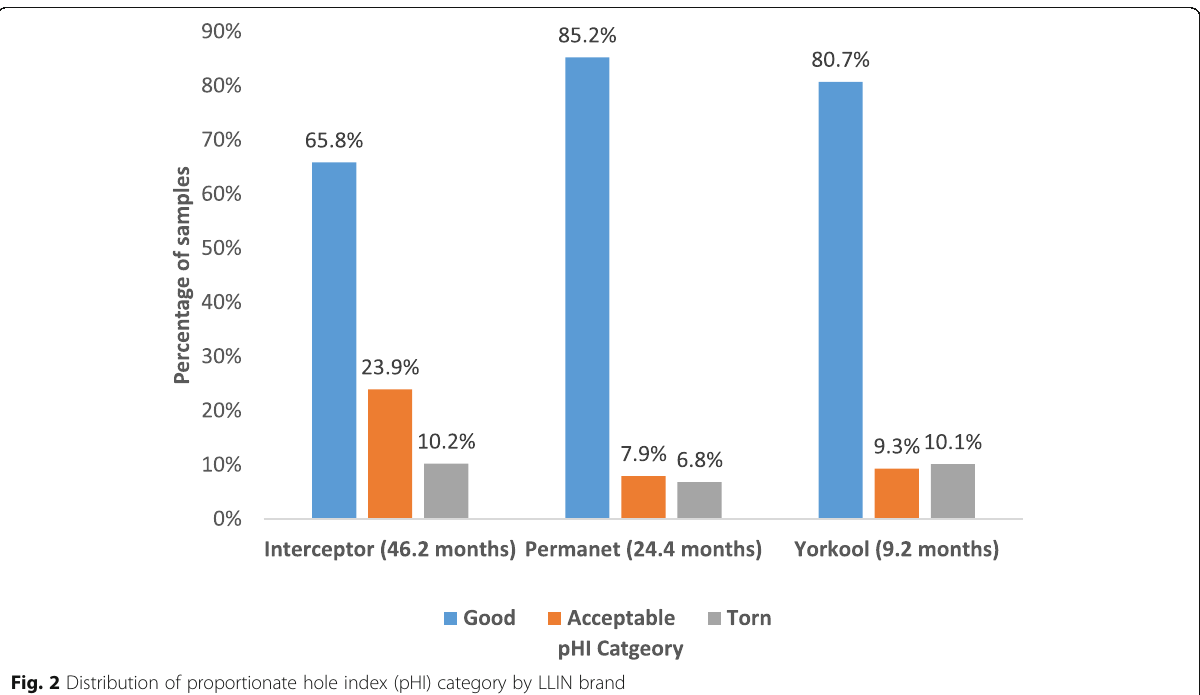
Fig. 2 Distribution of proportionate hole index (pHI) category by LLIN